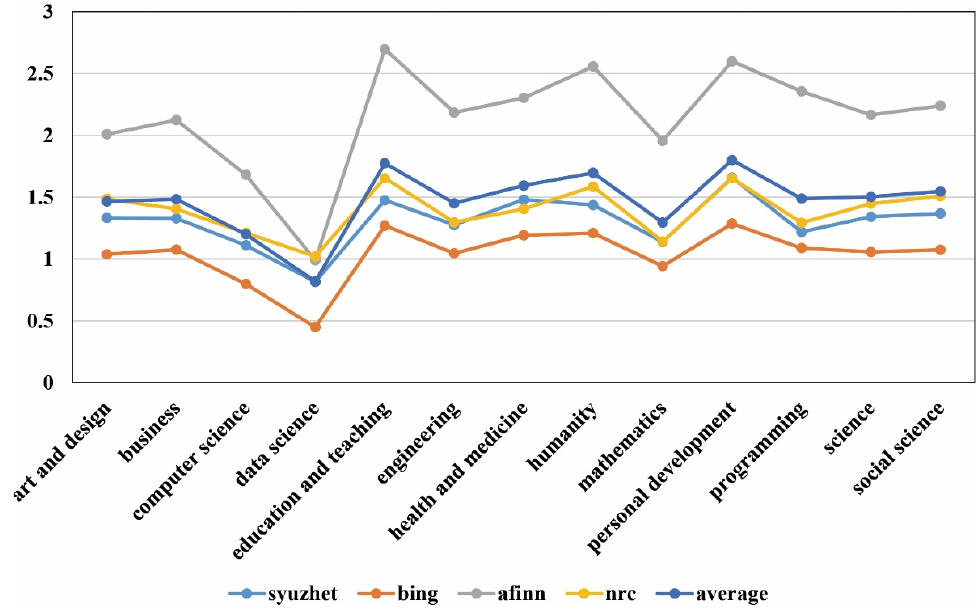
Figure 8. Averaged overall sentiment scores for each subject (calculated based on different methodologies).